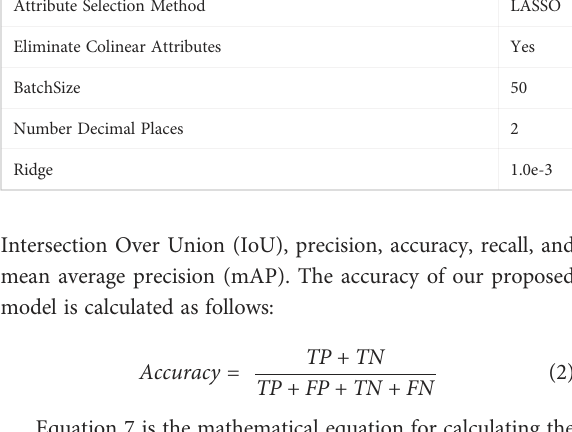
Table 5: shown the parameters linear regression model.